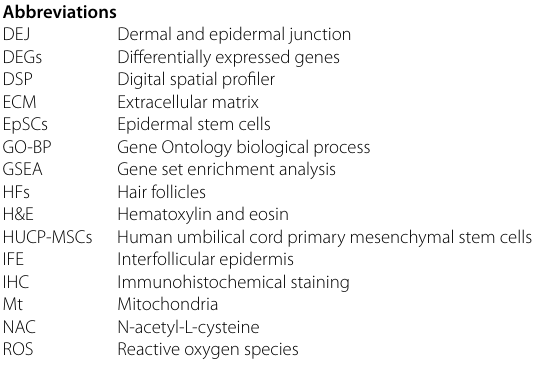
Figure S8. 24-, 48-, and 72-h time points tissue cytokine profiling and four-color Flow CytoMetry (FCM) of different targets showing quantifica- tion of CD3 + , CD4 + , and CD8 + T cells, as well as of Th 1 , Th 2 , Th 17 and Treg subgroups. A. FCM quantification of CD4 + and CD8 + cell distribution in all three groups. B. T-bet + /CD4 + T-cell distribution, double checked against IFN-γ + /CD4 + T-cell distribution. C. GATA3 + /CD4 + T-cell distribution, double-checked against IL-4 + /CD4 + T-cell distribution. D. IL-17A + /CD4 + T-cell distribution. E. CD25 high /CD127 low T-cell distribution. F. Example fig- ures of gating strategy used in cytometry flow test, and the first four plots showed procedure of gating strategy from one of the typical samples in Th 1 subgroup cells analysis, the form showed the cell abundance during the gating strategy. G. Pro-inflammatory cytokine profile (TNF-α, IL-1β, and IL-6), Th 17 -related cytokine (IL-17a and IFN-γ), and Anti-inflammatory cytokine IL-10 expression profile in all of the three groups at three time points. Data in A-C and G processed Two-way ANOVA test, and data in D and E processed unpaired t test. All data were plotted as Mean SEM. * ± P -value < 0.05; ** P -value <0.01; *** P -value < 0.001; no stars for P -value > 0.05. Supplemental Figure S9. High concentration of H 2 promoted early mussel and nerve repair. A. Left: Scheme of a mouse gastrocnemius strike model. Right: Timeline of animal experiments and daily H 2 treatment. B. Capture of the gastrocnemius strike area and blood perfusion 0-72 hours post-wounding in the 66% H 2 Control groups. C. & D. Quantification of diameter and blood perfusion of the gastrocnemius strike area between two groups. E. & F. Representative immunofluorescence images for NFH